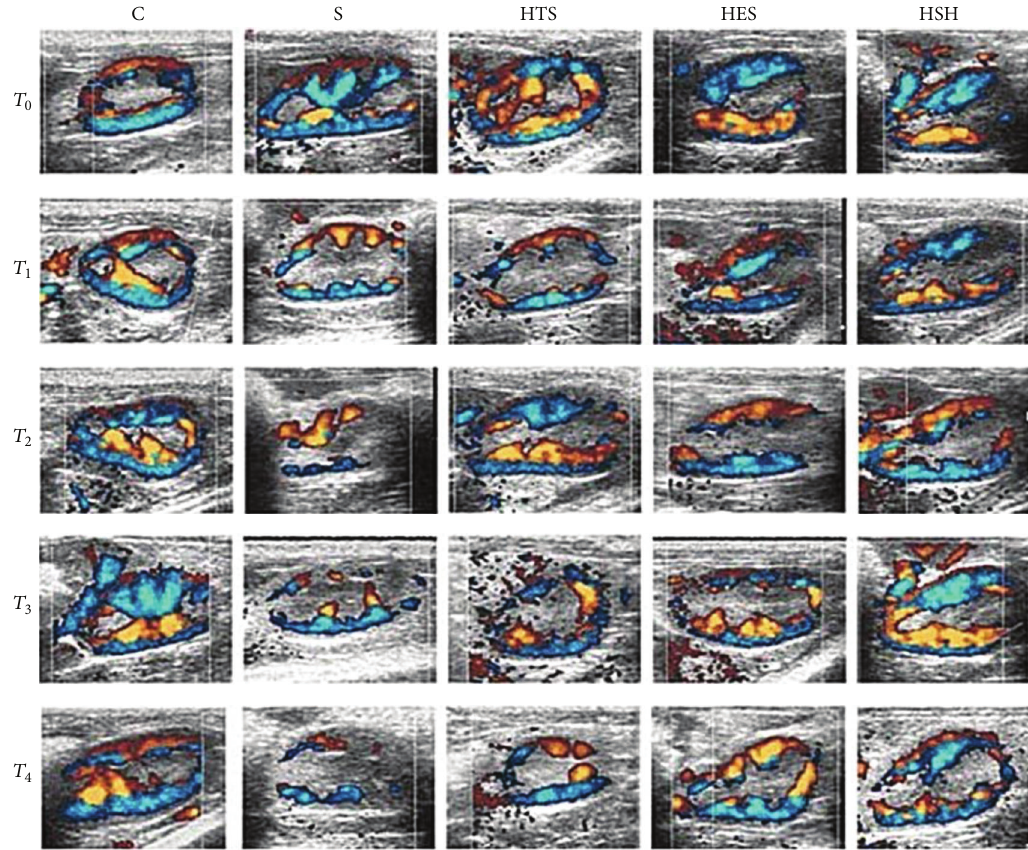
Figure2:Colorvelocityimaging(CVI)ofkidneyatleftrenaldoorcross-sectionallevel.IngroupCandothergroupsatthe 𝑇 0 timepoint,renal blood flow signals were strongly and uniformly distributed with adequate cortical perfusion, while it decreased dramatically with discrepant distribution and weak cortical perfusion at 𝑇 1 in the four experimental groups, among which there existed some degree of improvement with time in the HTS, HES, and HSH